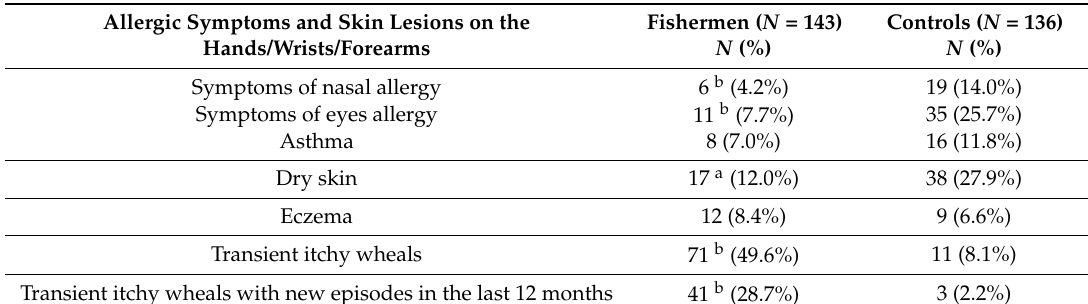
Table 3. Frequency distribution of allergic symptoms, dry skin, eczema and transient itchy wheals on the hands/wrists/forearms investigated with the NOSQ in the fishermen and controls.